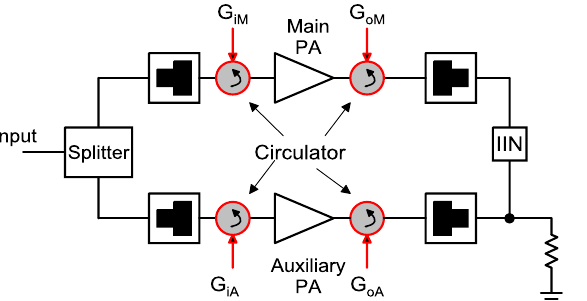
Figure 9. Implementation of the stability test on the Doherty power amplifier. IIN, Impedance Inverting Network.